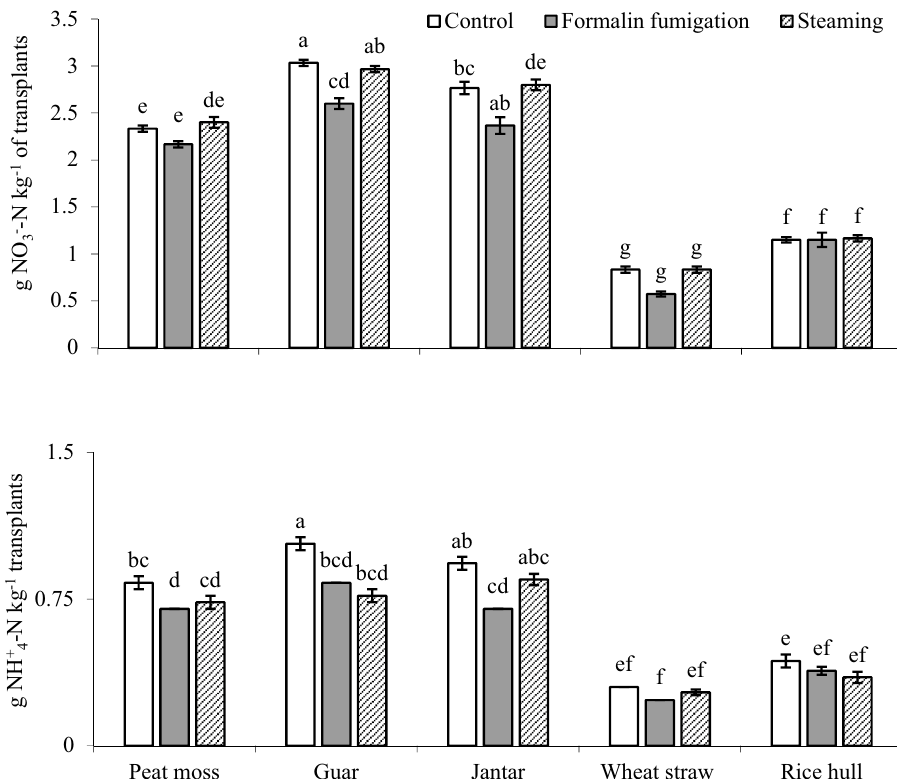
Figure 3. Inorganic-N concentrations: NO 3 − –N and NH 4 + –N concentrations in muskmelon transplants as influenced by sanitation techniques. All the values are means ± S.E of three replicates, whereas case letters indicate significant differences among the treatments at p ≤ 0.05 level.